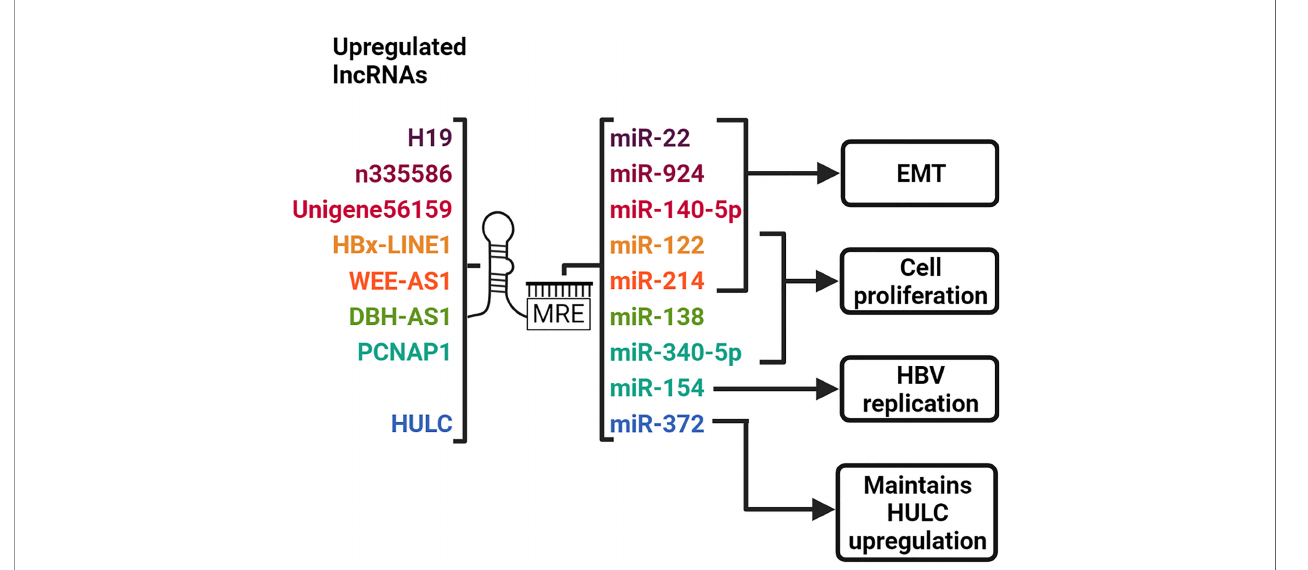
FIGURE 4 | LncRNAs act as ceRNAs to sequester complementary miRNAs. LncRNAs harbor MREs which allow them to bind to miRNAs with complementary sequences. H19, n335586 and Unigene56159 promotes EMT by sequestering miR-22, miR-924 and miR-140-5p, respectively. HBx-LINE1 and WEE2-AS1 promotes EMT and cell proliferation by sponging miR-122 and miR-214, respectively. DBH-AS1 increases cell proliferation by sequestering miR-138. PCNAP1 sponges miR-340-5p and miR-154 to promote cell proliferation and HBV replication, respectively. HULC sequesters miR-372, thereby maintaining its upregulation. Created with